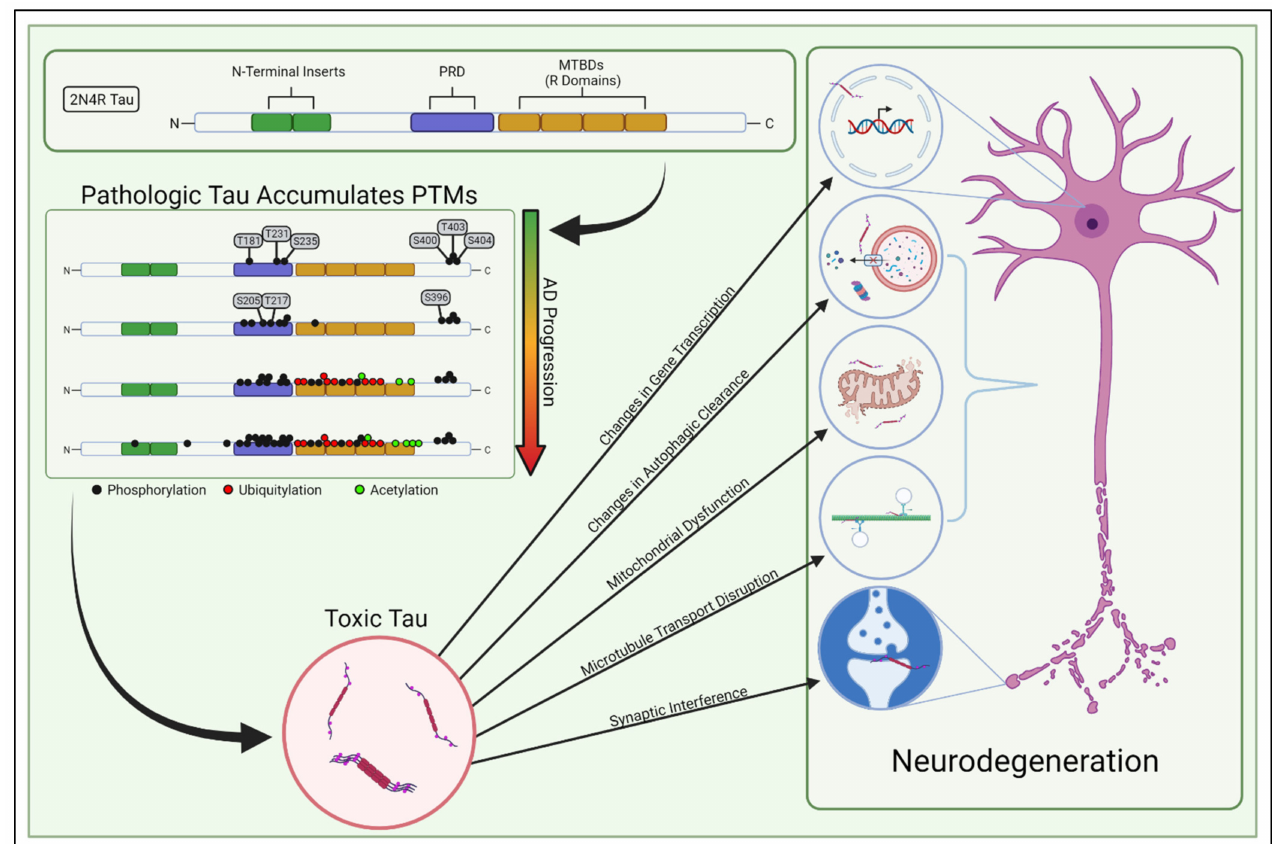
Figure 1. PTM-mediated tau toxicity. Tau isoforms contain up to two N-terminal domains and either 3 or 4 “R domains” (2N4R tau shown, though sporadic AD involves both 3R and 4R tau). The proline-rich domain (PRD) is just upstream of the MTBDs and commonly contains PTMs. The abundance of these PTMs increases stoichiometrically as AD progresses and generates toxic tau species which are likely involved in neurodegeneration. The PTM panel above was inspired by Wesseling et al.